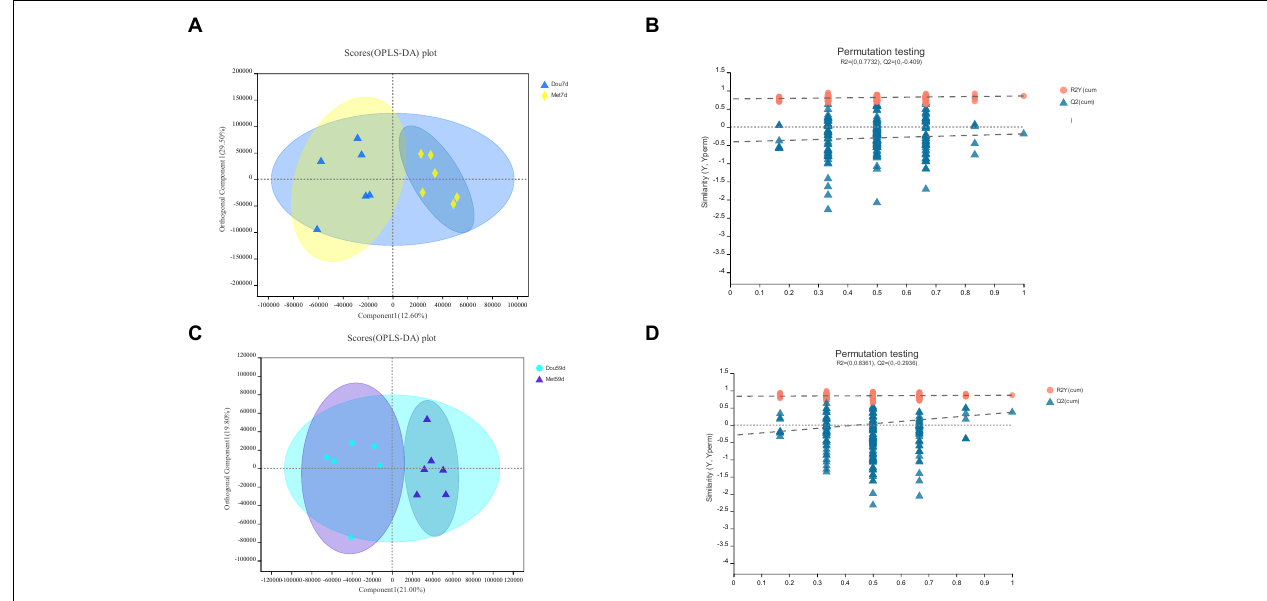
FIGURE 4 | In Met vs. Dou, panels (A,B) for 7th day and panels (C,D) for 59th day. Panels (A,C) are OPLS-DA scores plot. Panels (B,D) are OPLA-DA permutation tests. (B) R 2 X (cum) = 0.421, R 2 Y (cum) = 0.855, Q 2 = − 0.188. (D) R 2 X (cum) = 0.408, R 2 Y (cum) = 0.867, Q 2 = 0.374.